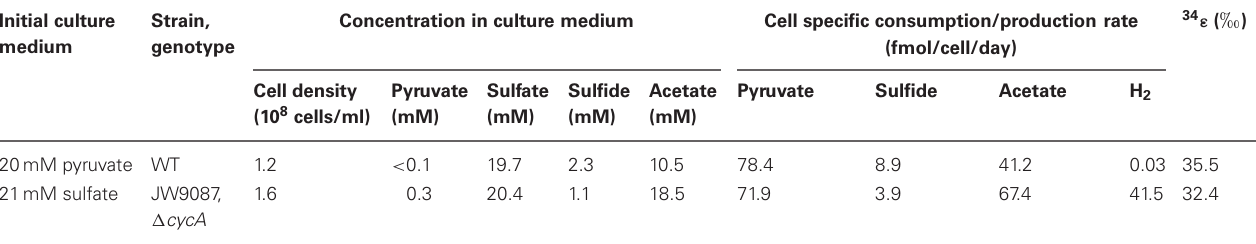
Table 3 | Metabolites and sulfur isotope fractionation in continuous cultures of wild-type Desulfovibrio vulgaris Hildenborough and CycA